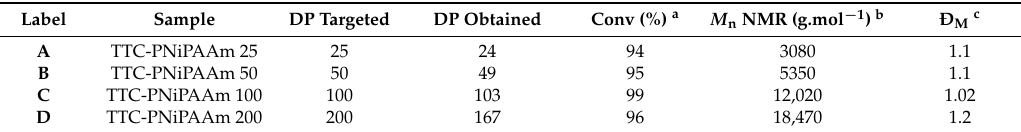
Table 2. General parameters of the synthesized TTC-PNiPAAm samples.